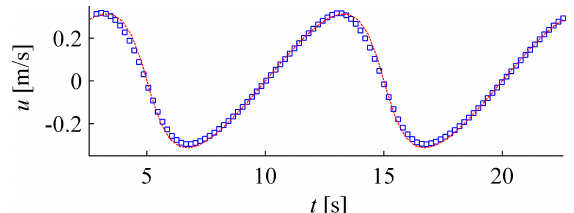
Figure 6. Shoreline velocity of monochromatic wave run-up on a planar beach. Comparison between adopted model (blue dotted lines) and the analytical solution by Carrier and Greenspan [28] (continuous red lines).